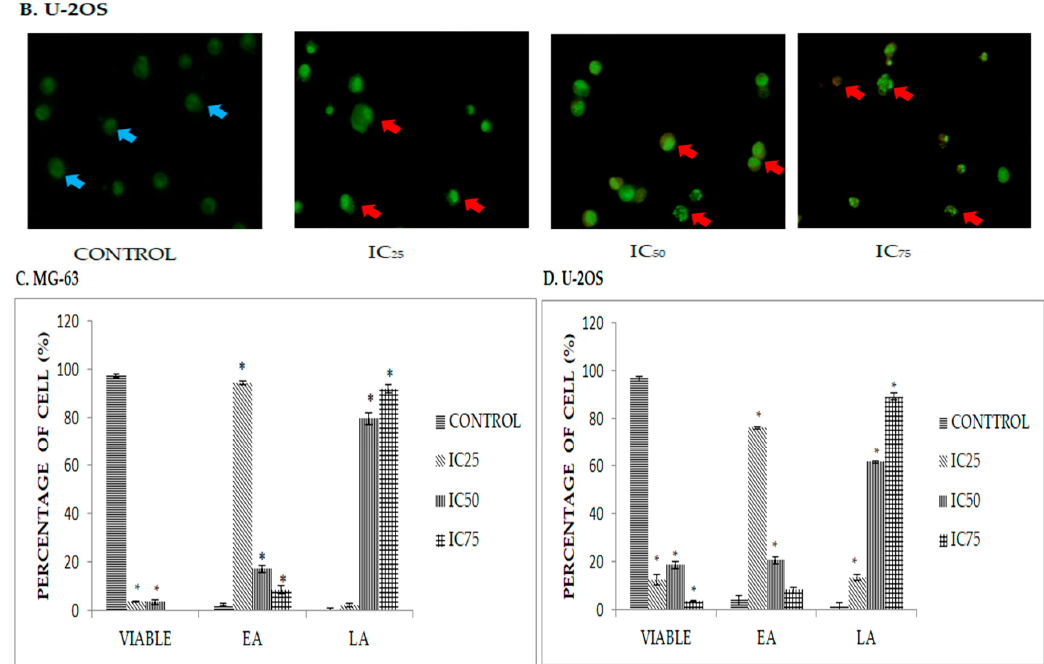
Figure 2. ( A ) Distinct morphological changes in MG-63 after 48 h of treatment with DK1 (IC 25 (6.6 µM), IC 50 (23.8 µM), and IC 75 (30 µM)); ( B ) Distinct morphological changes in U-2OS after 48 h treatment with DK1 (IC 25 (2.2 µM), IC 50 (19.6 µM) and IC 75 (30 µM)); ( C , D ) Quantification analysis of MG-63 and U-2OS based on cells uptake of acridine orange and propidium iodide in 200 cells. (Blue arrow: viable; red arrow: apoptosis). EA (early apoptosis), LA (late apoptosis). All data are expressed as mean ±